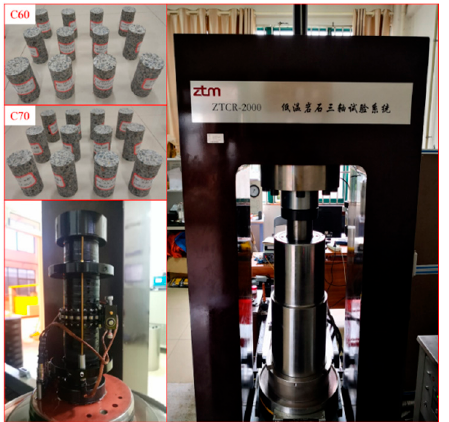
Figure 1. ZTCR-2000 rock triaxial testing system.